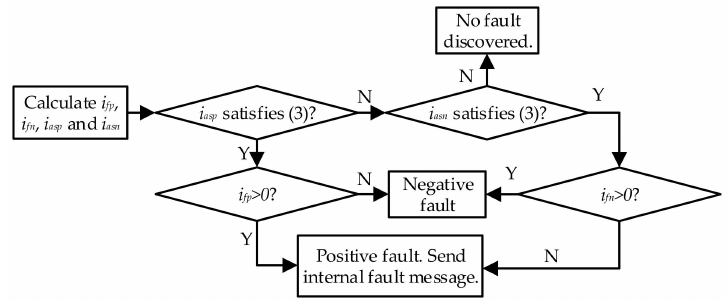
Figure 5. The flowchart for directional element of grid-connected